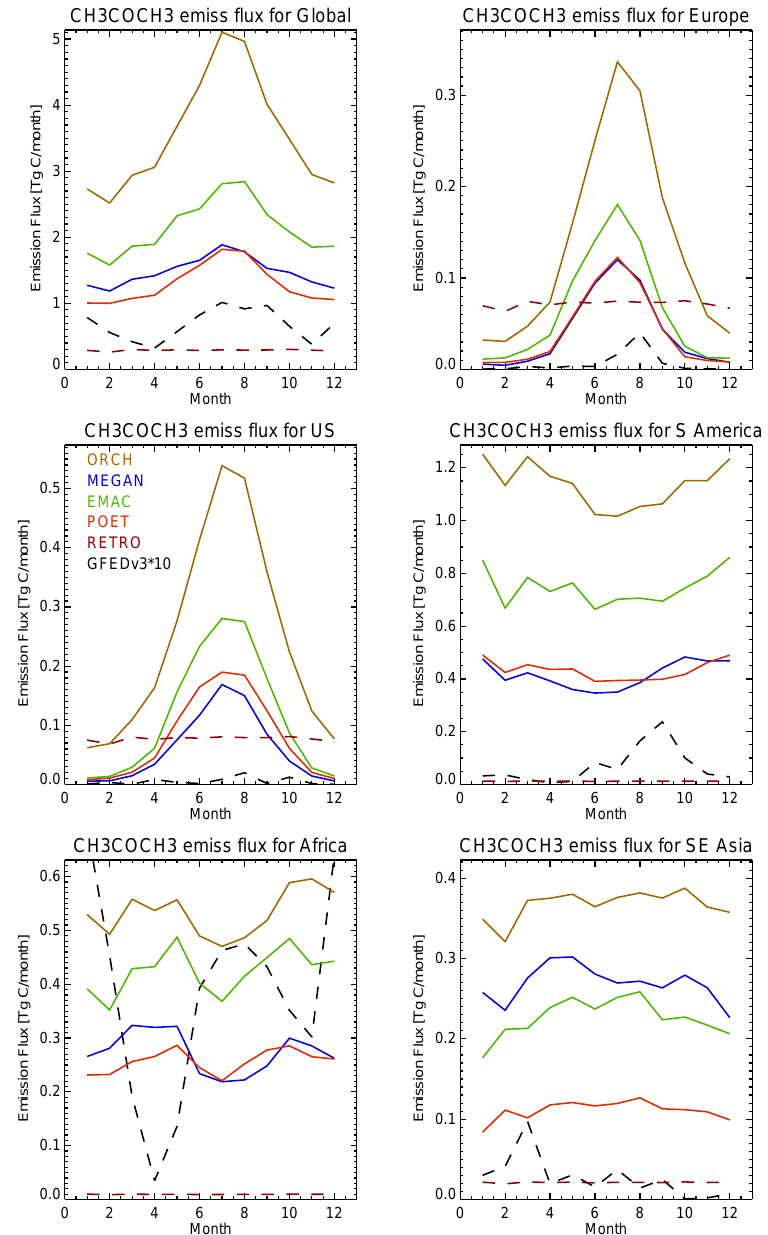
Fig. 2d. As for Fig. 2a. except for CH 3 COCH 3 . Note that in these panels the biomass burning contribution scaled up by